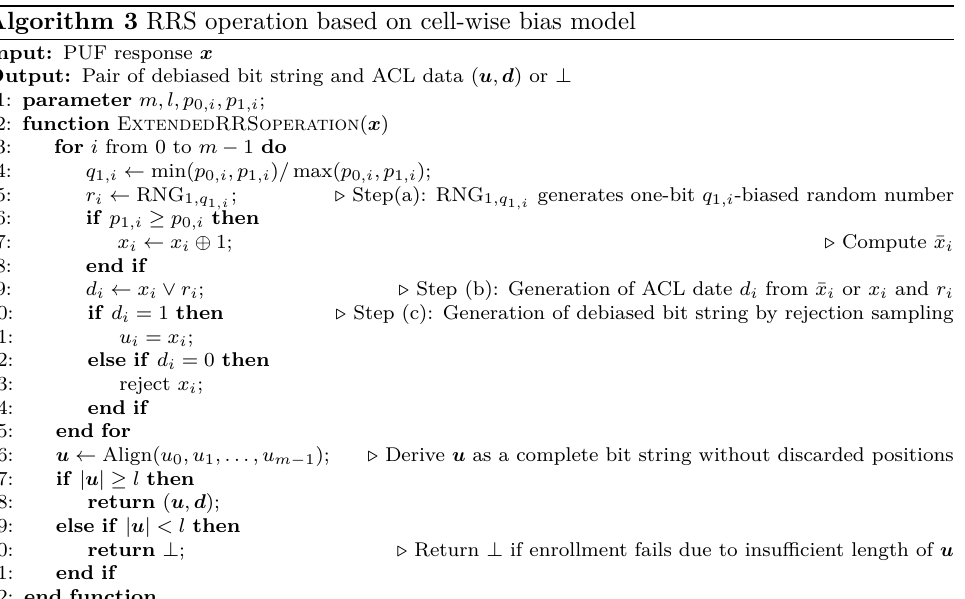
Algorithm 3 RRS operation based on cell-wise bias